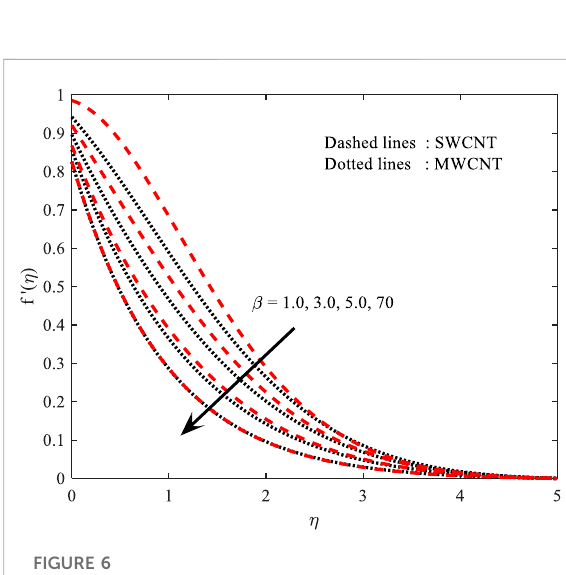
FIGURE 6 Impact of the hydrodynamic interaction parameter on f ′ ( η )